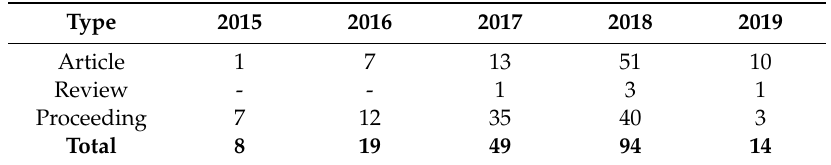
Table 1. Numbers of papers in Web of Science (WoS) database based on the query “Industry 4.0” OR “Industrial revolution 4.0” AND TOPIC “construction” OR “building”.